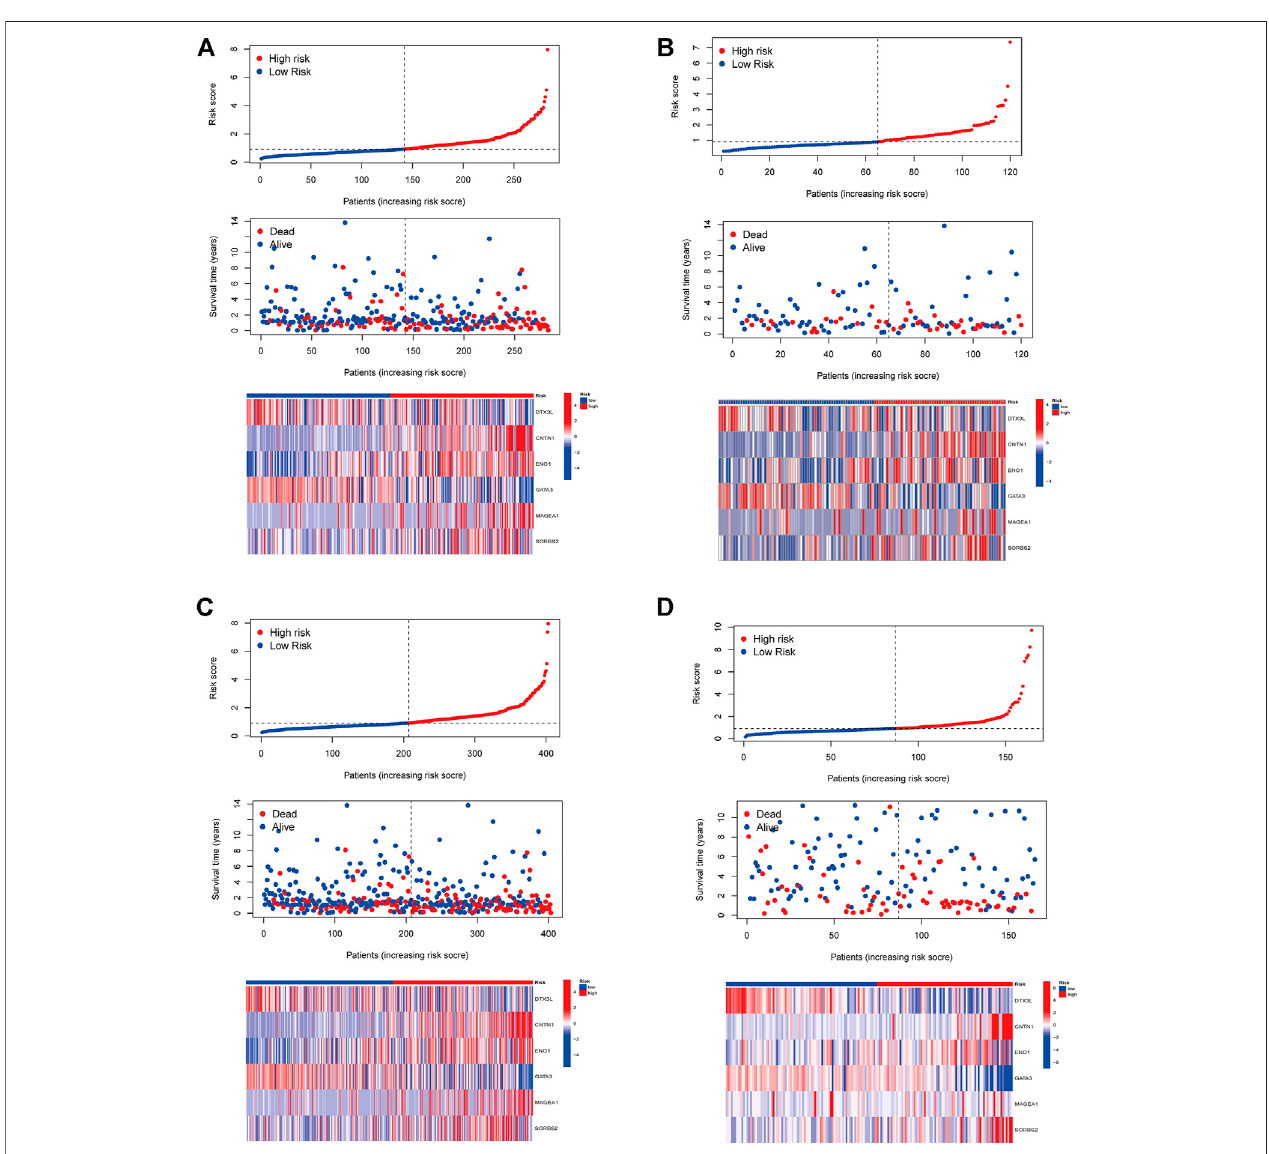
FIGURE 4 | The distribution of the BCa patients with risk scores in different cohorts. Distribution of patients by risk score in low- and high-risk groups and the expression levels ofthe sixsignature genes weredisplayed asa heatmap in TCGA training cohort (A) ,TCGAtesting cohort (B) , entire TCGA cohort (C) , and GSE13507 cohort (D)